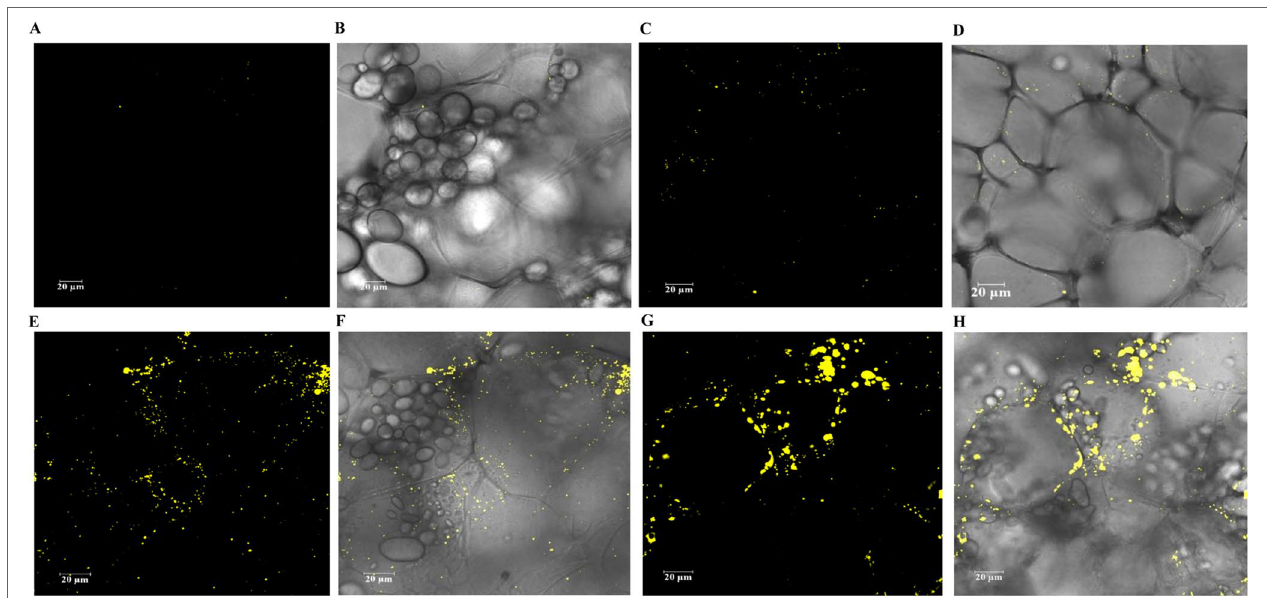
FigURE 8 | Confocal scanning microscopy analysis of the LDs distribution in mature potato tubers. The LDs were stained with BODIPY (yellow), bright-field images of the unstained starch granules and cell wall structures formed the major background contrasted to the LDs. (A , B) Visualization of LDs in WT. (c , D) Visualization of LDs in WT-L5. (E , F) Visualization of LDs in HO69. (g , h) Visualization of LDs in 69-L3. The scale bars are located in the lower left corner for each photograph, sizes of the scale bars are all normalized to 20 μm.